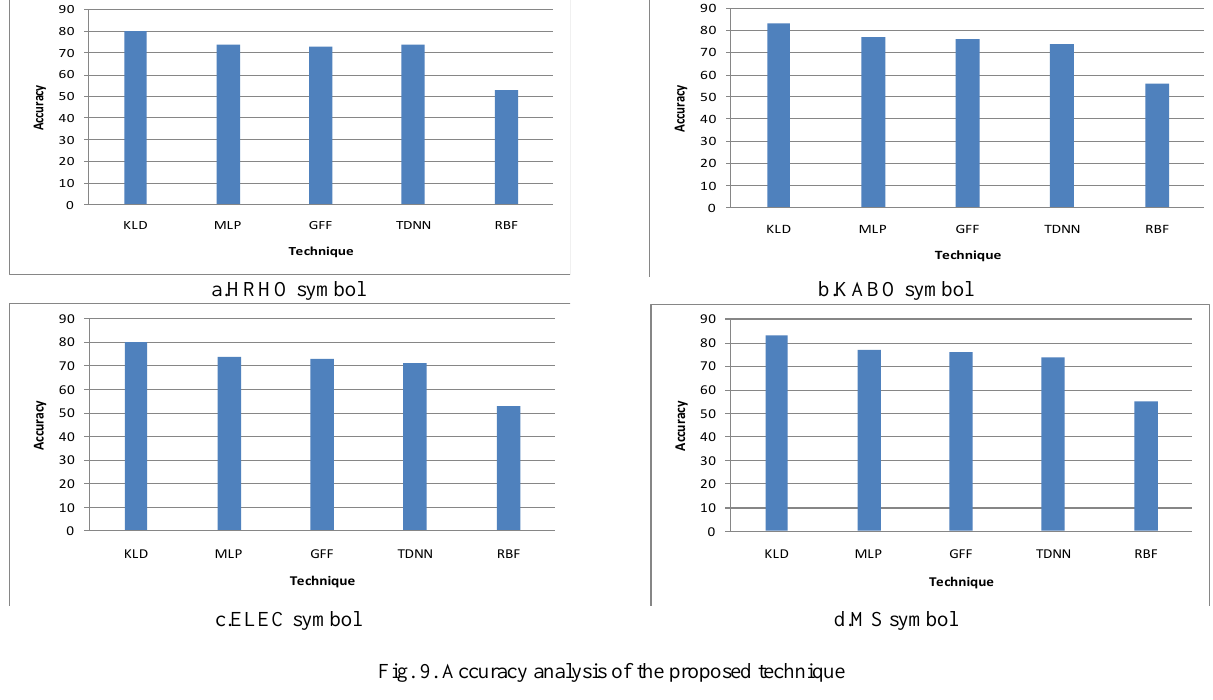
Fig. 9. Accuracy analysis of the proposed technique